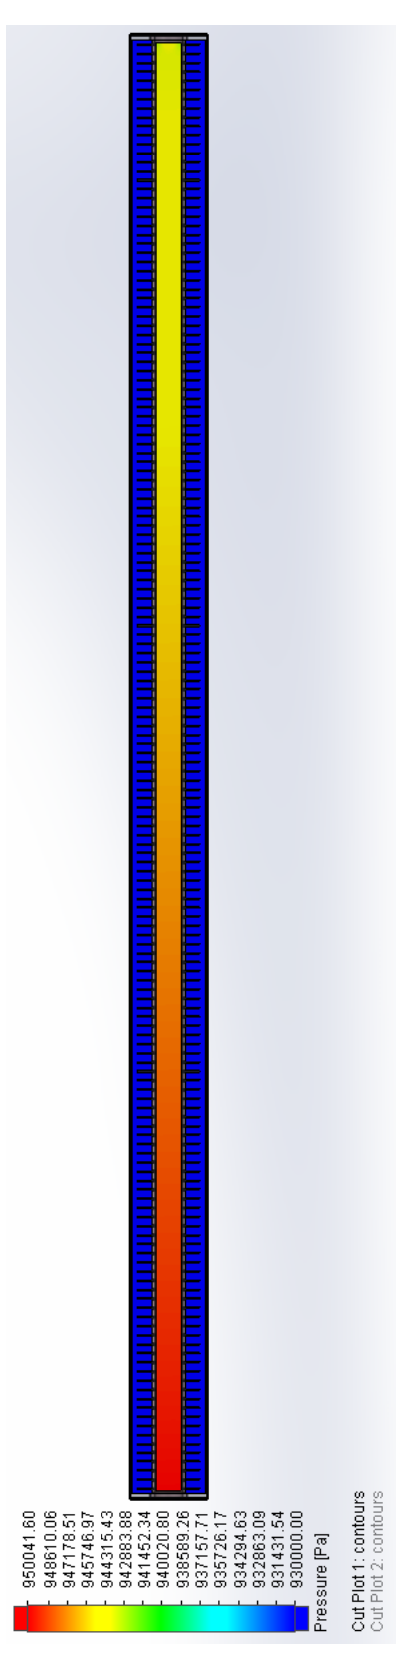
Figure 13. Section side view of pressure plot, with the scale of measurement optimize for R134a internal